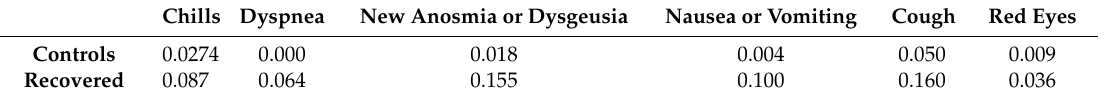
Table 7. Absolute risk of groups (controls and recovered) presented the day of the interview.